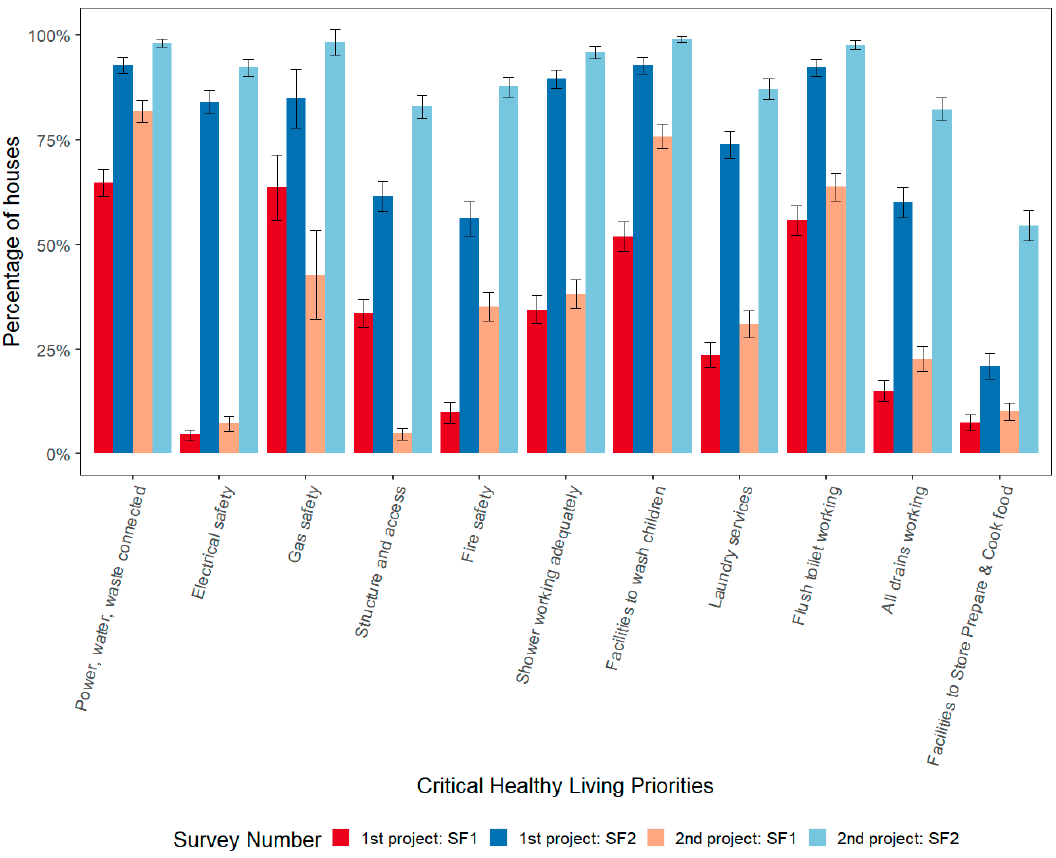
Figure 5. Percentage of houses with Critical Healthy Living Priorities fully met for NSW projects with repeat visits at First Project SF1 ( n = 802) and SF2 ( n = 722); and at Second Project SF1 ( n = 788) and SF2 ( n = 734) from 1998–2017.